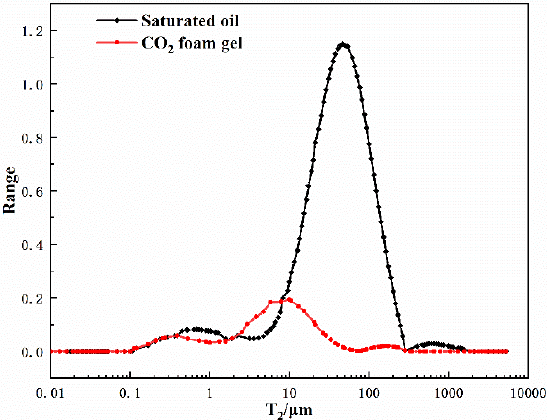
Figure 6. NMR T 2 spectra of core No.2 before and after injection of CO 2 foam gel.